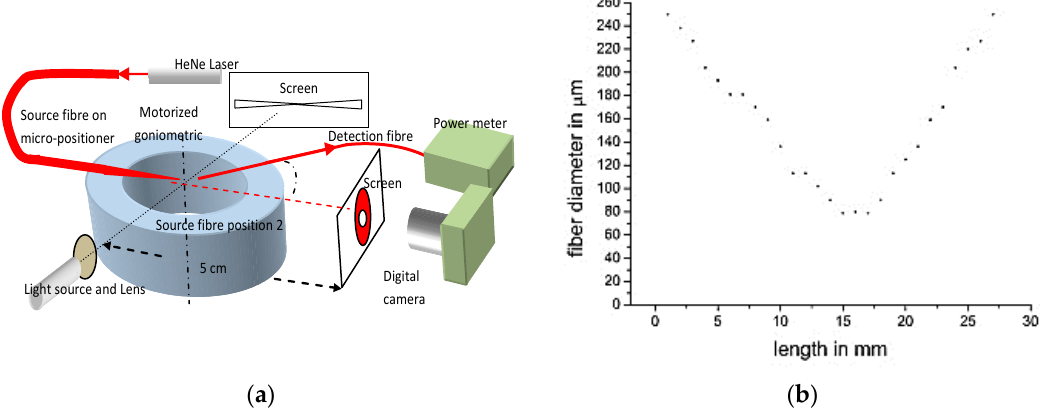
Figure 2. ( a ) Experimental arrangement used to measure the taper geometry, ( b ) Fiber taper measurements side-profile.